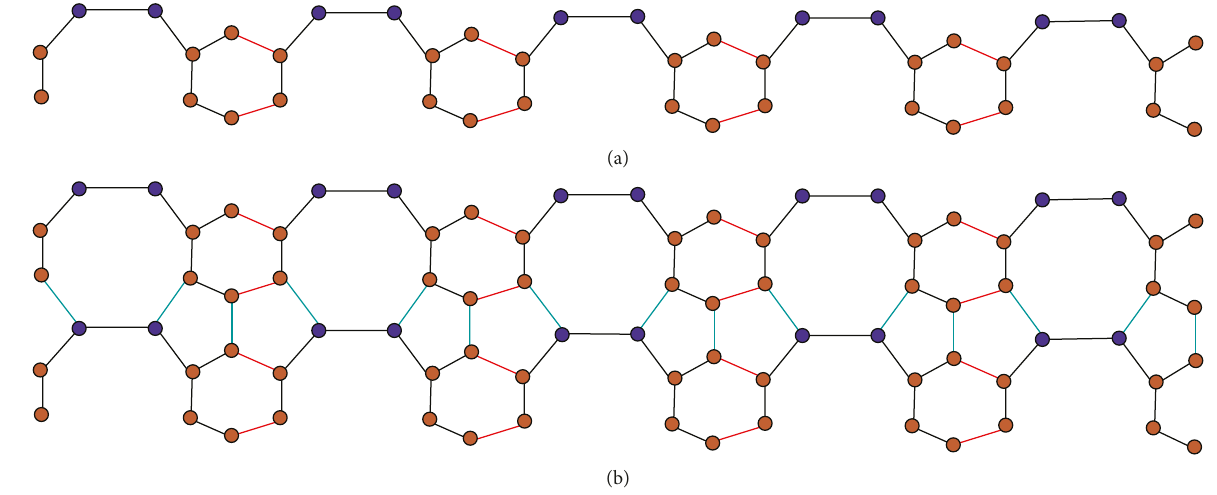
Figure 7: The unit cell and SiC